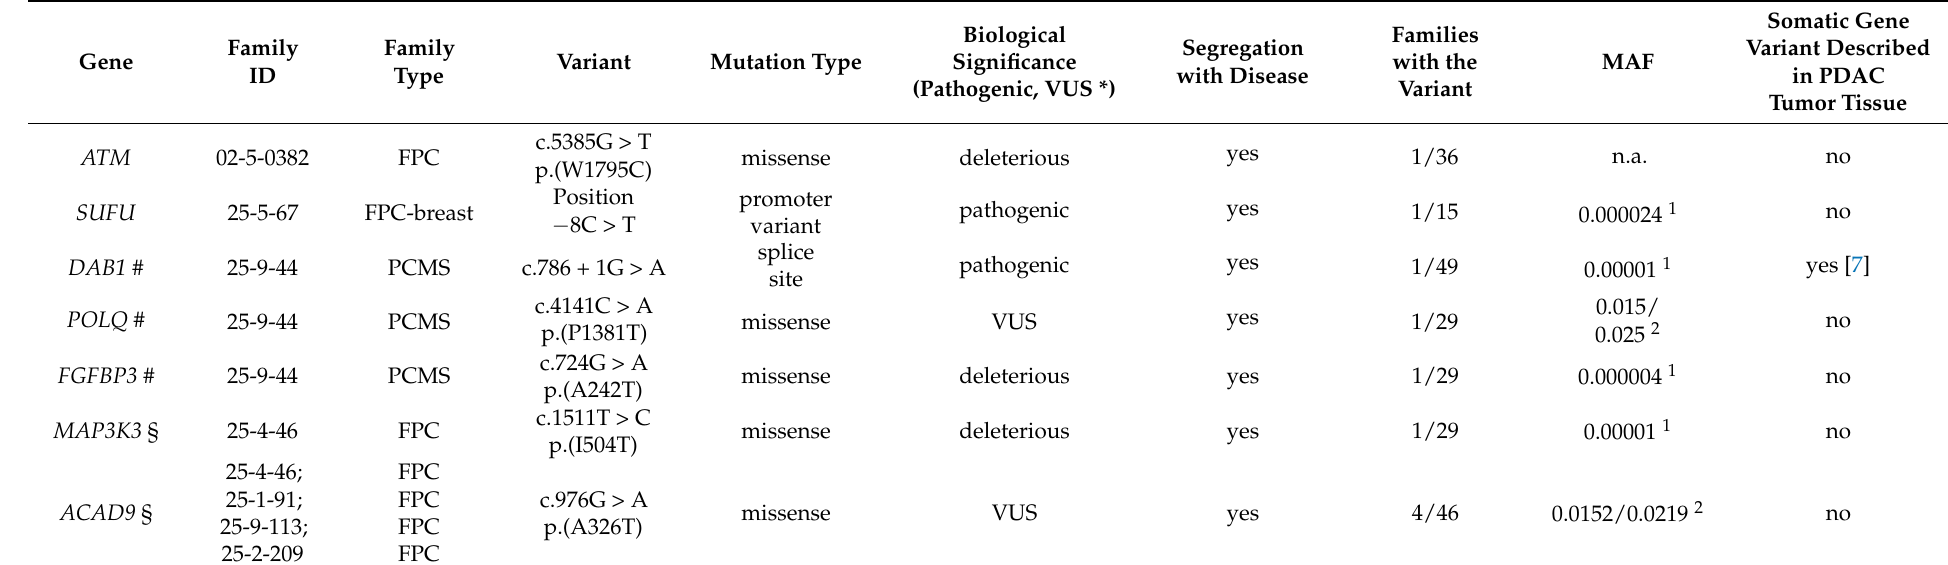
Table 1. Summary of major findings of whole-genome sequencing analyses in FPC